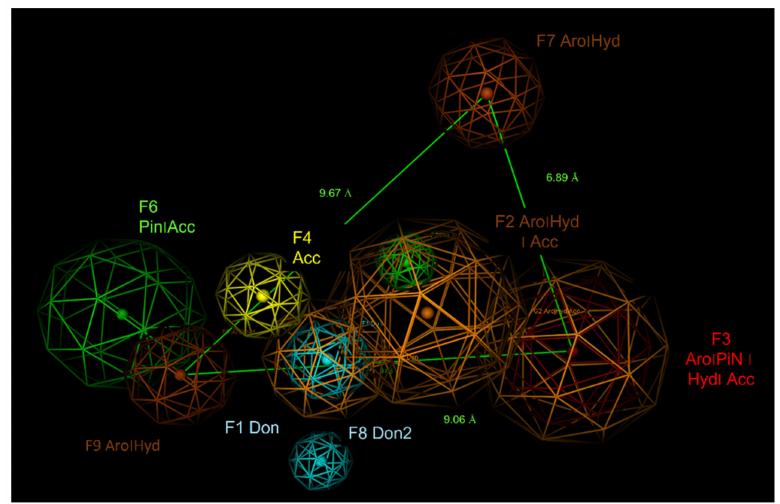
Figure 13. The main pharmacophore requirements experienced by hybrids are reported along with their related distances, focusing on F3, F7, andF9 groups. H-bonding groups are named as F Acc and F Don while aromatic features are reported as F